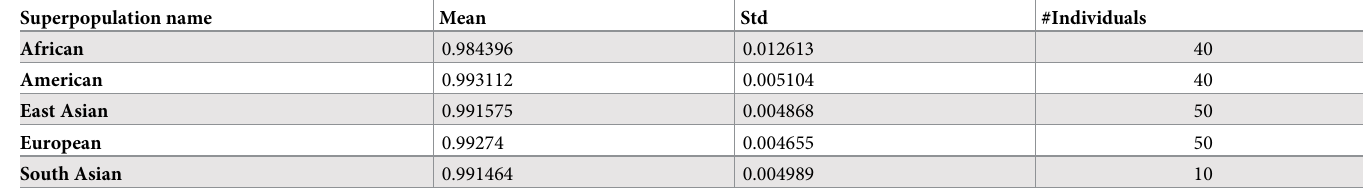
Table 4. Accuracy for different superpopulations in chips Affymetrix, Omni, Customized. Accuracy as measured by concordance (Po) of the imputation results for each of the five main super populations.